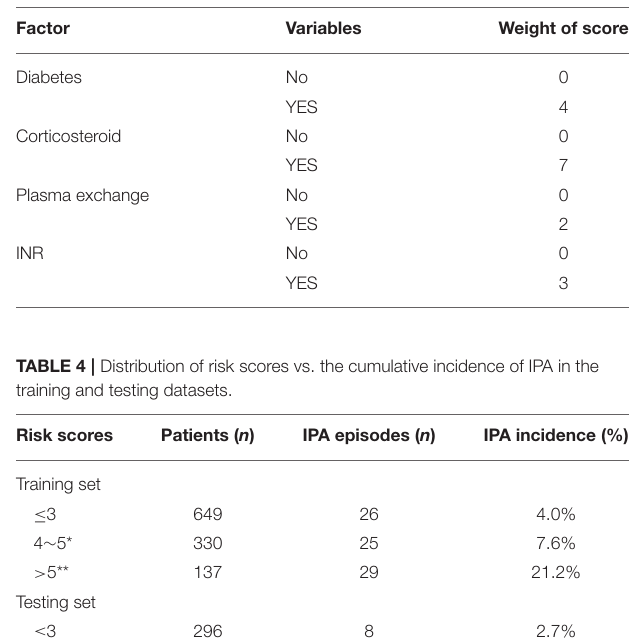
TABLE 3 | Risk scores for IPA.